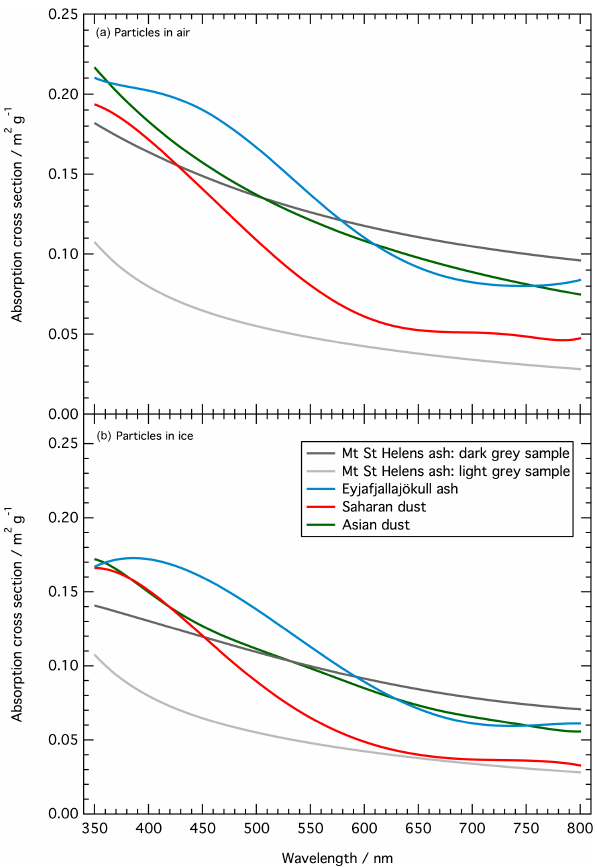
Figure 2. Absorption cross-section values based on Mie theory calculations undertaken here. Particles were considered to be sur- rounded by air at a temperature of 0 ◦ C (a) for snow; and sur- rounded by ice (b) , using refractive index data for ice from Warren and Brandt (2008) for sea ice. The size distribution of the particles used in the Mie calculation was fixed to a log normal distribution peaking at 2.3µm with a standard deviation of 2.1µm. The data were smoothed with a polynomial fit to remove the fine wavelength